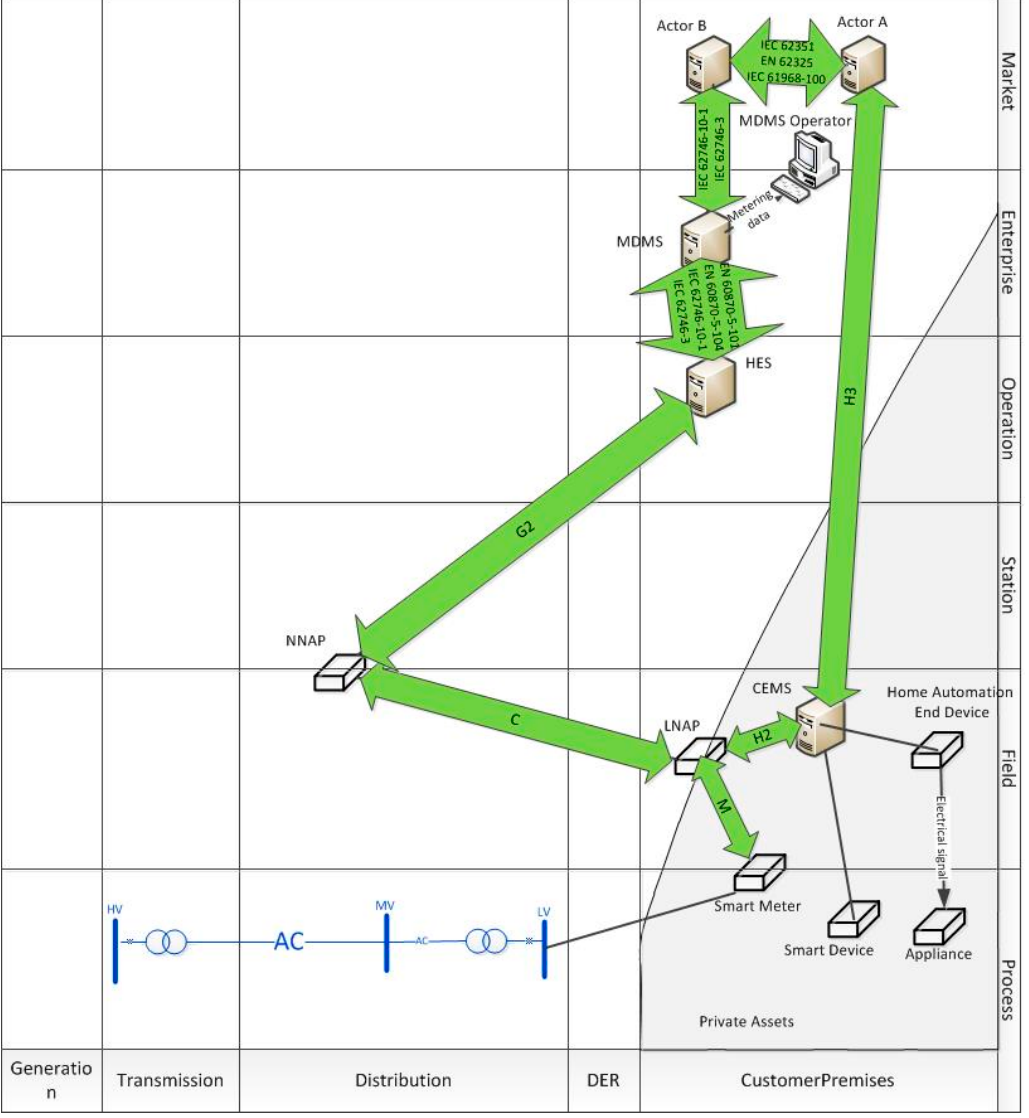
Figure 8. Communication Layer.